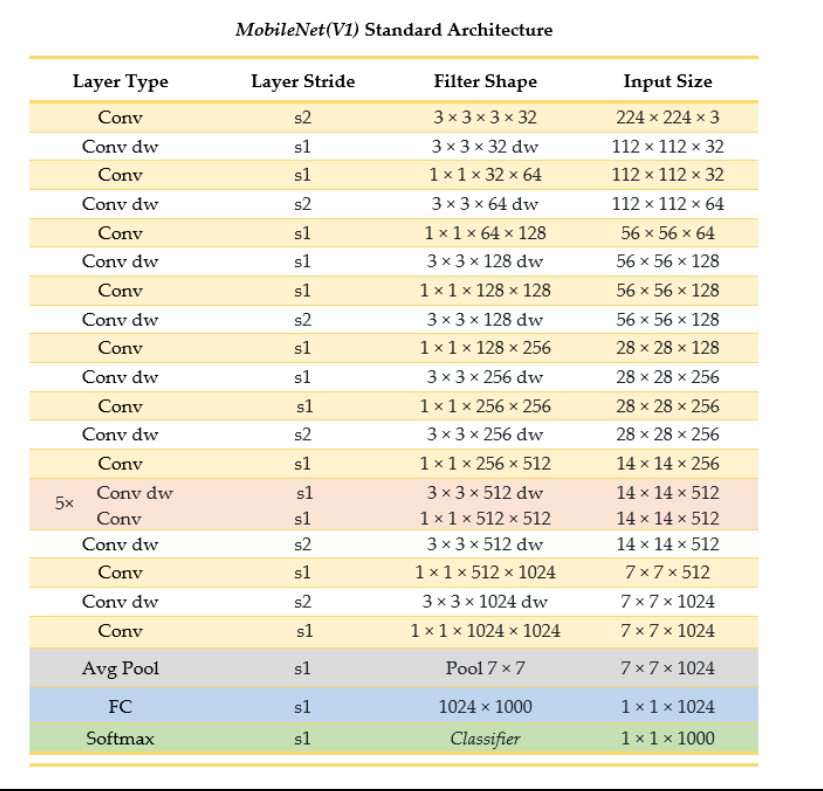
Figure 7. MobileNetV2 architecture summary (as outlined in [25]).